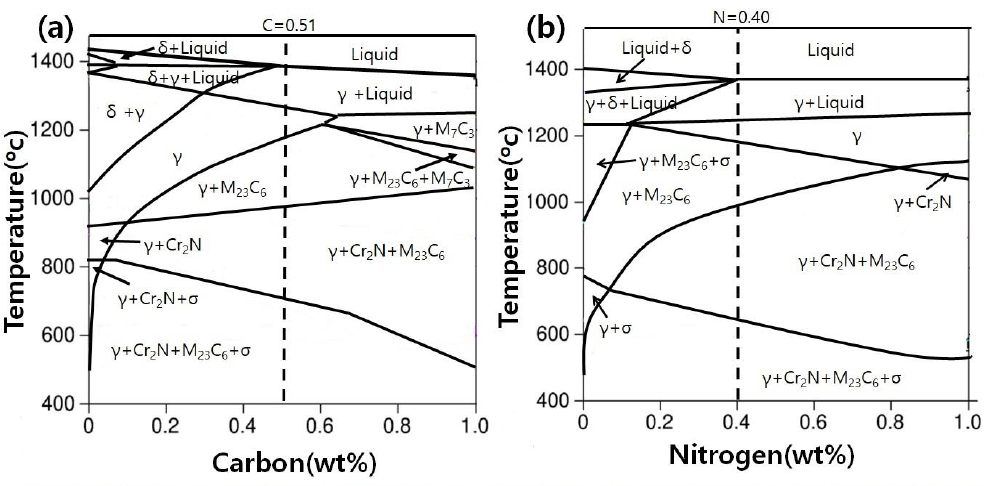
Figure 2. Isopleth diagrams showing the stability of phases such as ferrite, austenite, Cr 2 N, M 7 C 3 , σ , M 23 C 6 , and liquid in Fe-Cr-Mn-Ni stainless steel, as functions of temperature and carbon ( a ), or nitrogen ( b